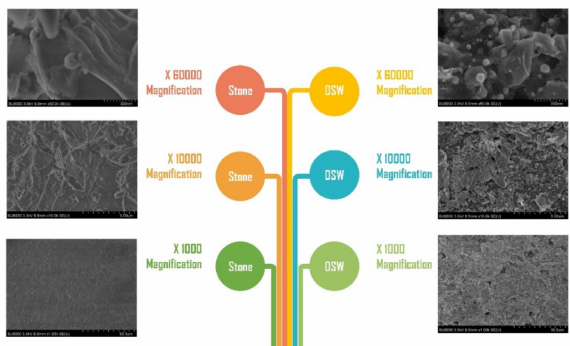
Figure 9. Scanning electron micrographs of stone and OSW with a grain size of 0.6